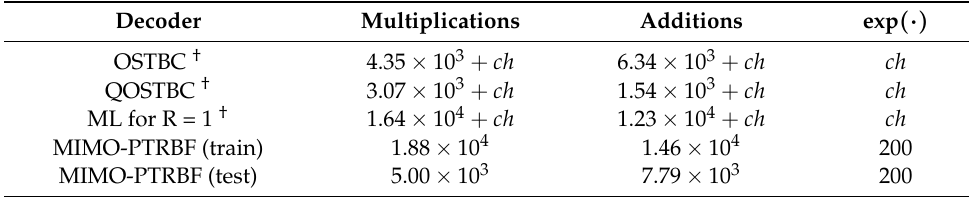
Table 3. Computational complexities for M T = M R = 4 and 2 bits/s/Hz.